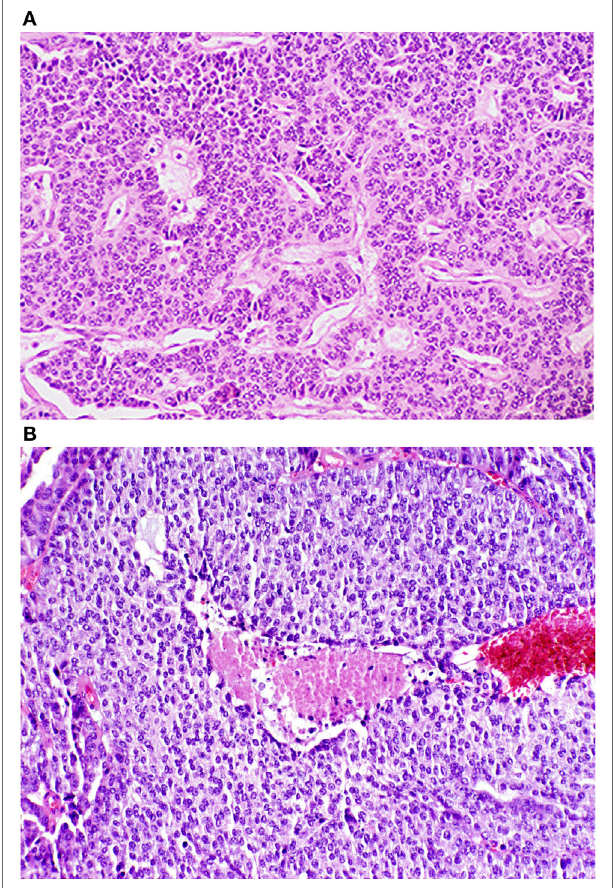
FiGURe 1 | Photomicrographs of typical and atypical pulmonary carcinoid tumors. (A) Low power photomicrograph of a typical pulmonary tumor. (B) Low power photomicrograph of an atypical pulmonary carcinoid tumor with central necrosis. Reproduced with permission from: Tazelaar HD. Pathology of lung malignancies. In: UpToDate, Post TW (Ed), UpToDate, Waltham, MA. (Accessed on November 2, 2016.) Copyright © 2016 UpToDate, Inc. For more information visit www.uptodate.com.